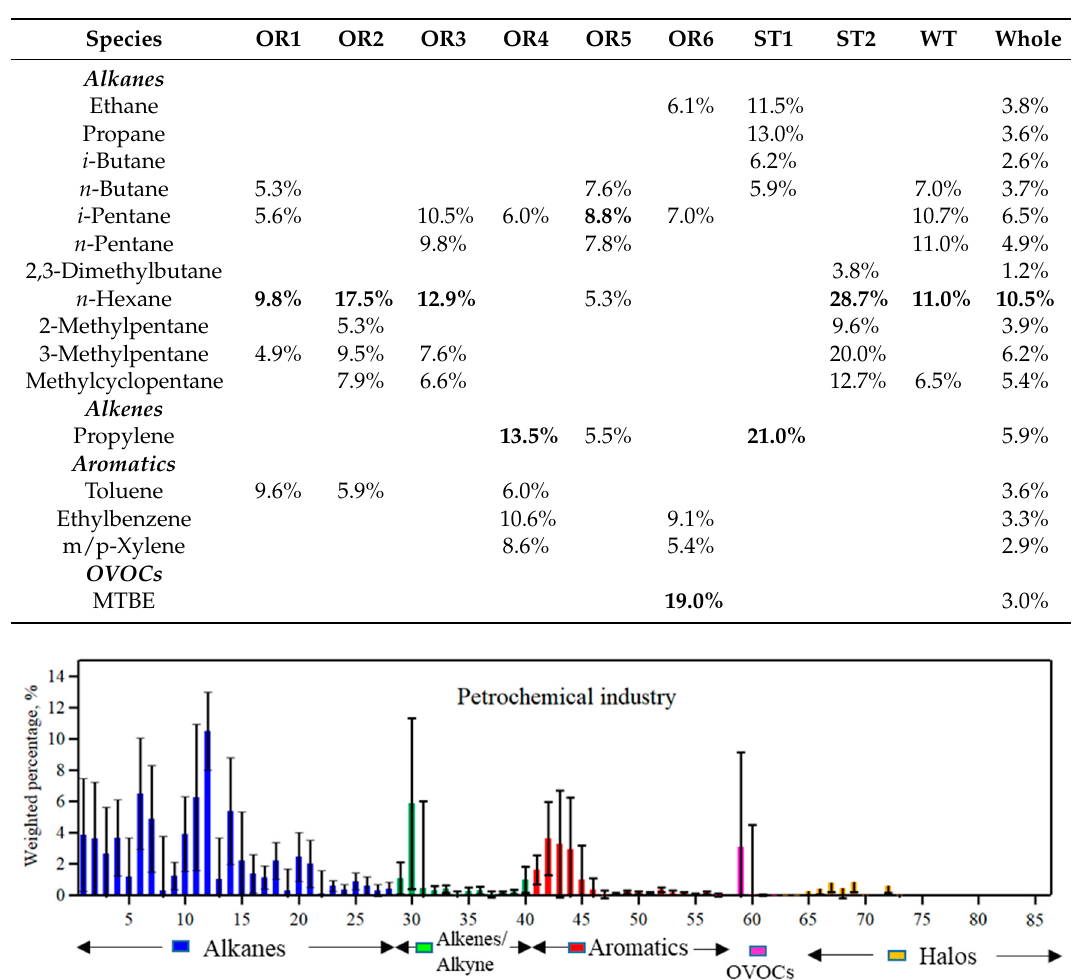
Table 2. The top five VOC species and their contributions to total VOC mass concentration measured in each unit.